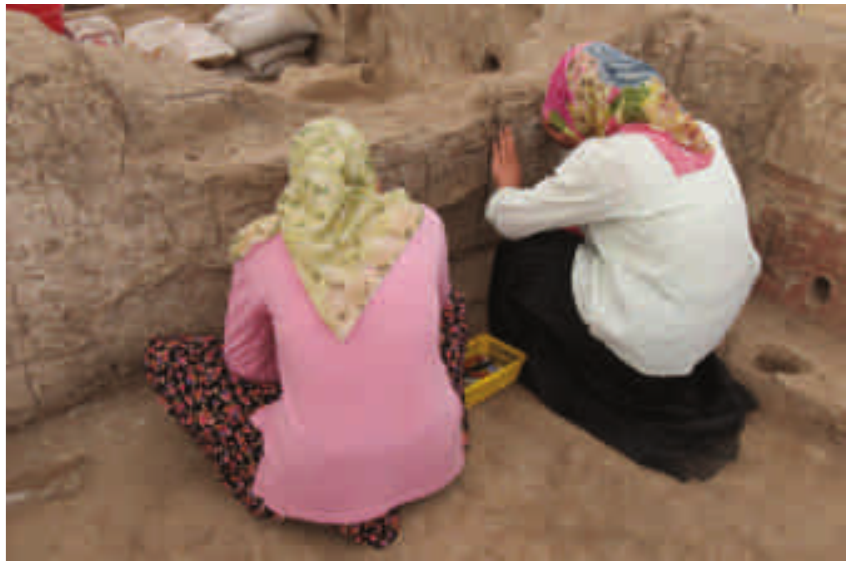
Figure 9 Local women uncovering pigment within plaster